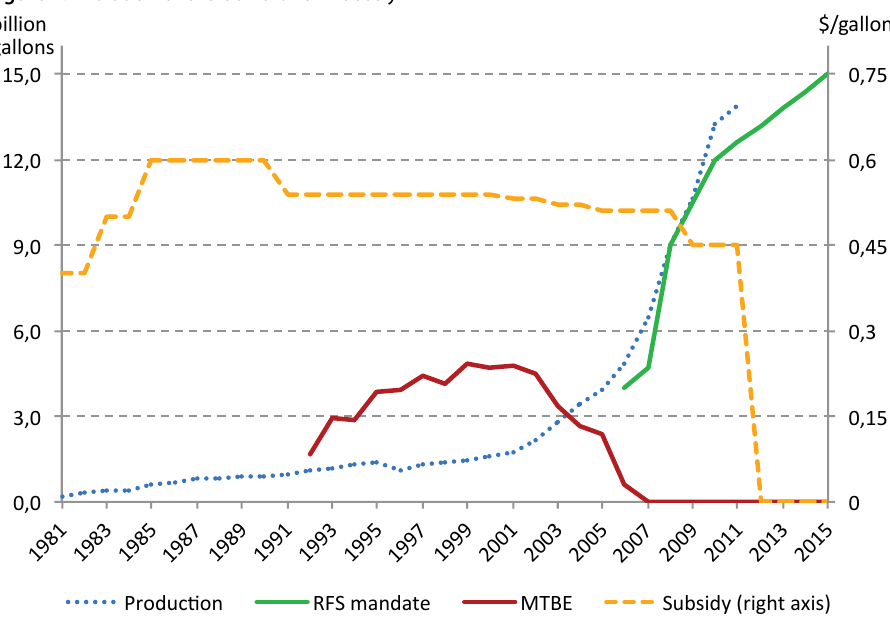
Figure 2. Evolution of the US Ethanol